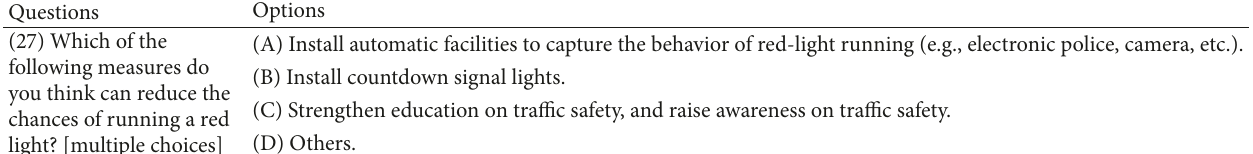
Table 9: Measures for reducing the chances of running a red light.